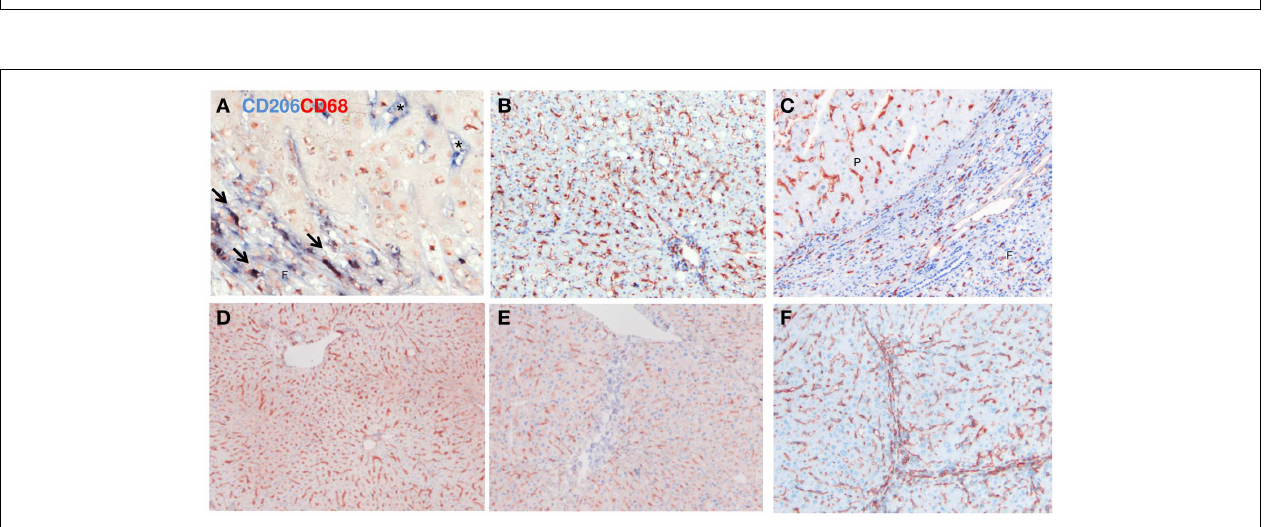
FIGURE 5 | Localization of IRF-5 (M1) in mouse and human livers . (A) Co-localization of IRF-5 and CD68 in mouse and human livers. (B) Double-staining for IRF-5 (blue staining) and CD206 (red staining) showed no co-localization. (C,D) Immunohistochemical staining of IRF-5 in normal